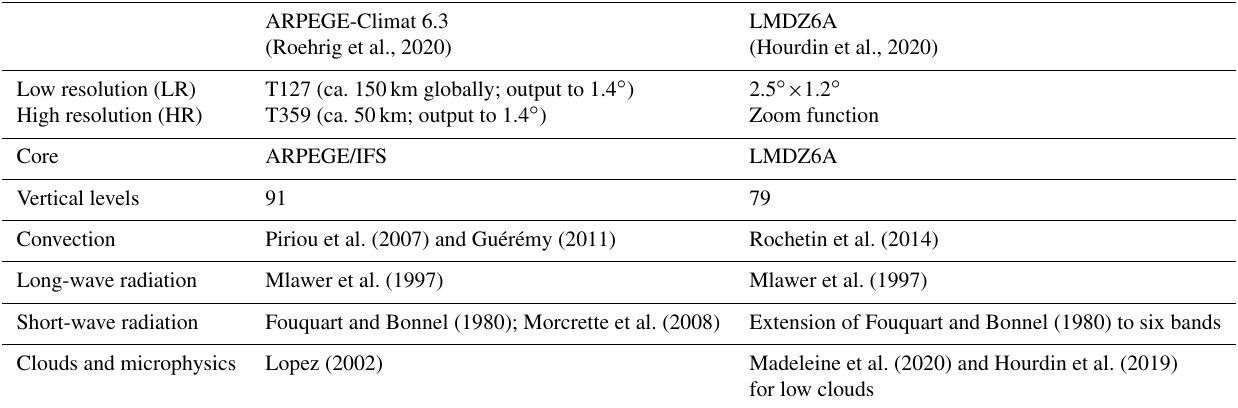
Table 1. Model descriptions with key parameterisations and hindcast